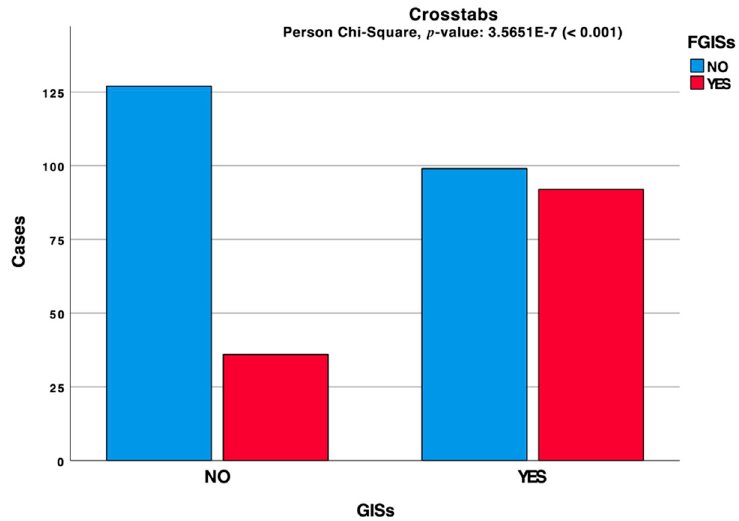
Figure 1. Clustered bar chart based on the contingency table related to the interactions between GISs and FGISs during the lockdown period.